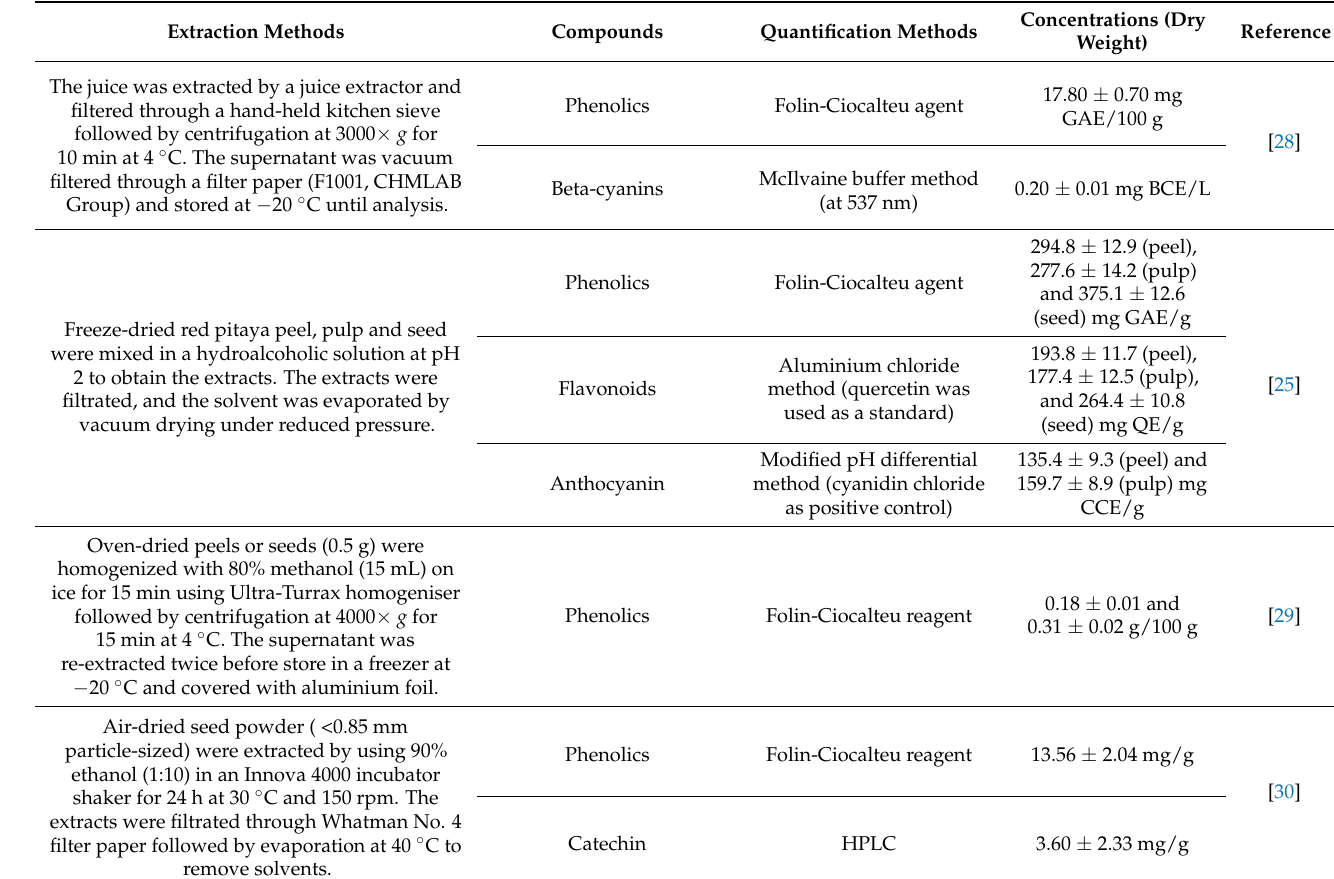
Table 2. The UPLC-MS/MS method was applied to identify the dominant phenolic